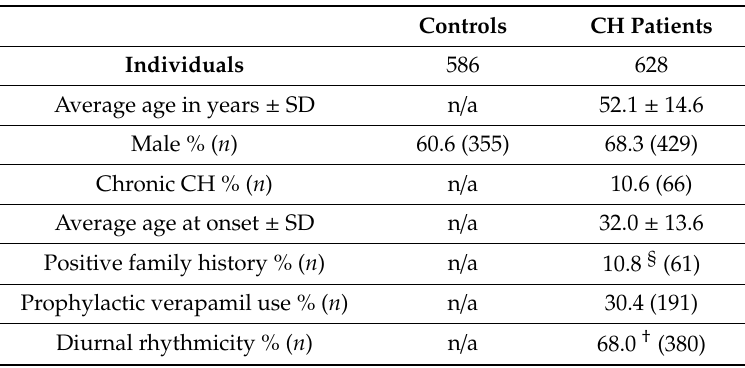
Table 1. Demographic data for patients and controls.